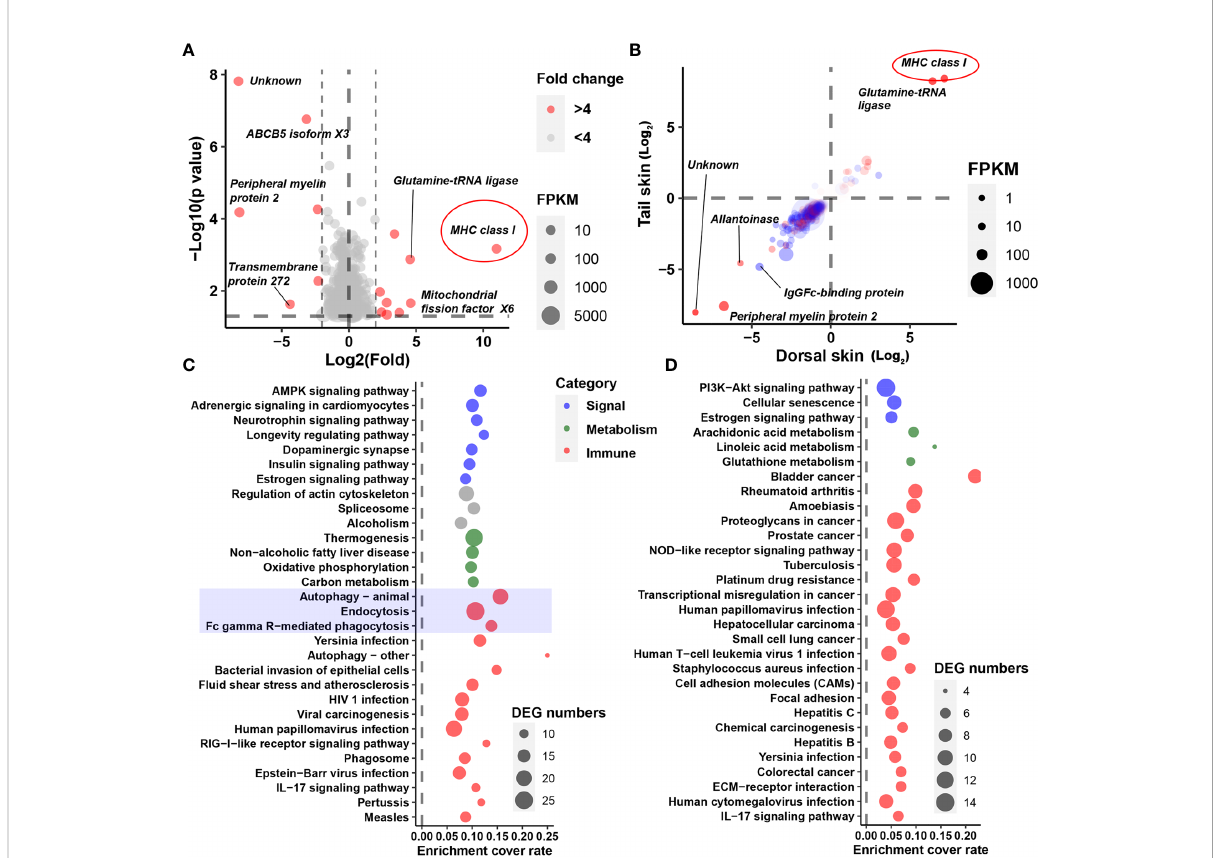
FIGURE 2 Identi fi cation of crucial DEGs and cellular processes. (A) The DEGs representing the greatest fold change in the brain. (B) Fold changes in DEGs ( p < 0.05) in the dorsal (horizontal axis) and tail (vertical axis) skins. Red dots denote DEGs shared by all three tissue types; blue dots denote DEGs shared by the two skin tissue types. Note that most DEGs exhibit consistent trends in variation (i.e., an increase or decrease) between the two types of skin tissue, indicating the reliability of the DEGs. (C, D) Functional analysis based on DEGs in the brain (C) or those shared by the skin samples (D) . Only the top 30 signi fi cant items are displayed ( q <